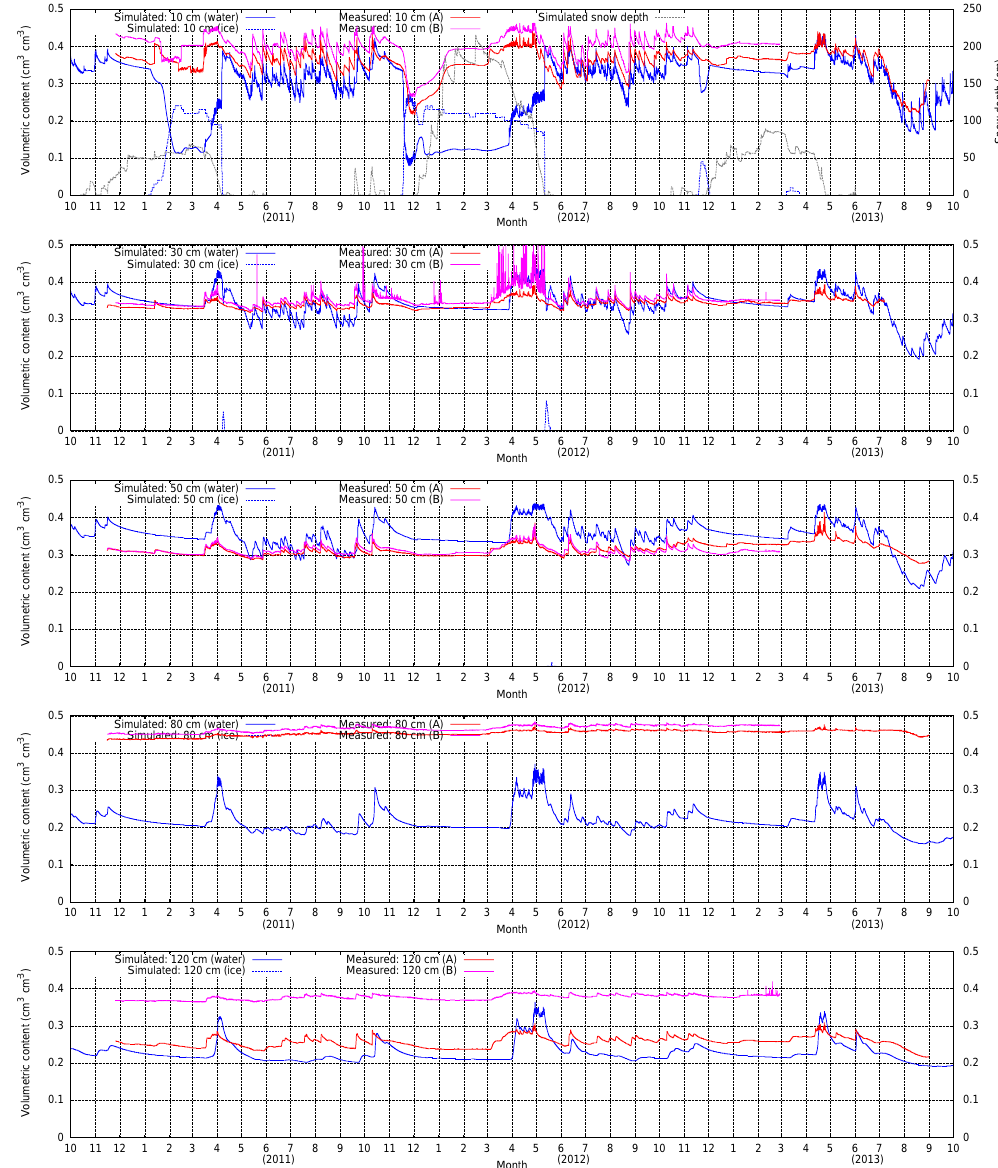
Figure 5. Measured and simulated soil moisture at the IRKIS station SLF2, for (from top to bottom) 10, 30, 50, 80 and 120cm depths for the period October 2010 to October 2013. In the upper panel, simulated snow depth is also shown.